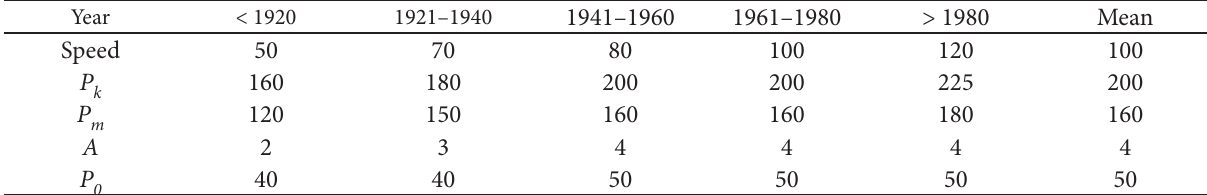
Table 1. Equivalent Freight Train according Sustainable Bridges:2006 : axle loads and numbers of axles per wagon Year <